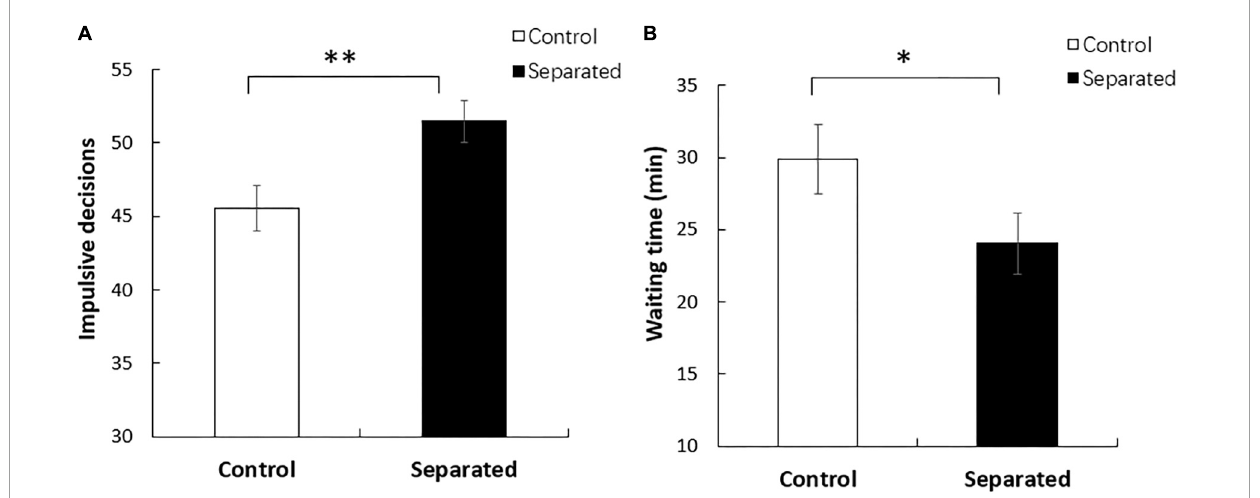
FIGURE1 (A) The number of impulsive decisions made by participants in the smartphone separation condition was significantly higher than those in the control condition ( p < 0.01). (B) Participants in the smartphone separation condition were less willing to wait than those in the control condition ( p < 0.05). ∗ p < 0.05; ∗∗ p <